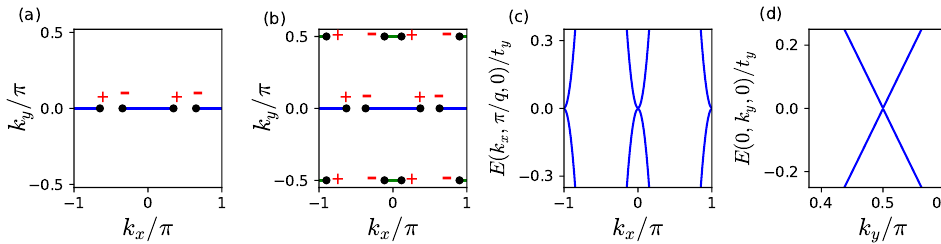
Figure 6: Fermi arcs on the surface BZ k M is taken to be 2.2 t